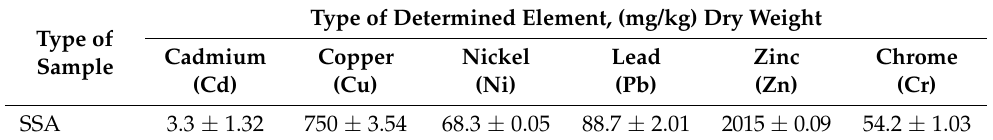
Table 3. The general contents of selected heavy metals in SSA